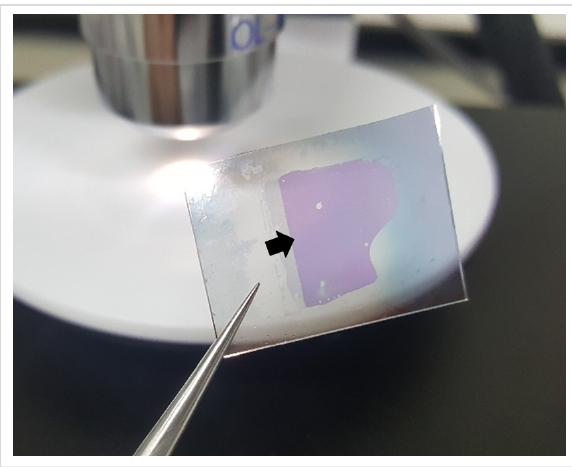
Figure 5: Photograph of transparent glass with Ag nanoparticle arrays.